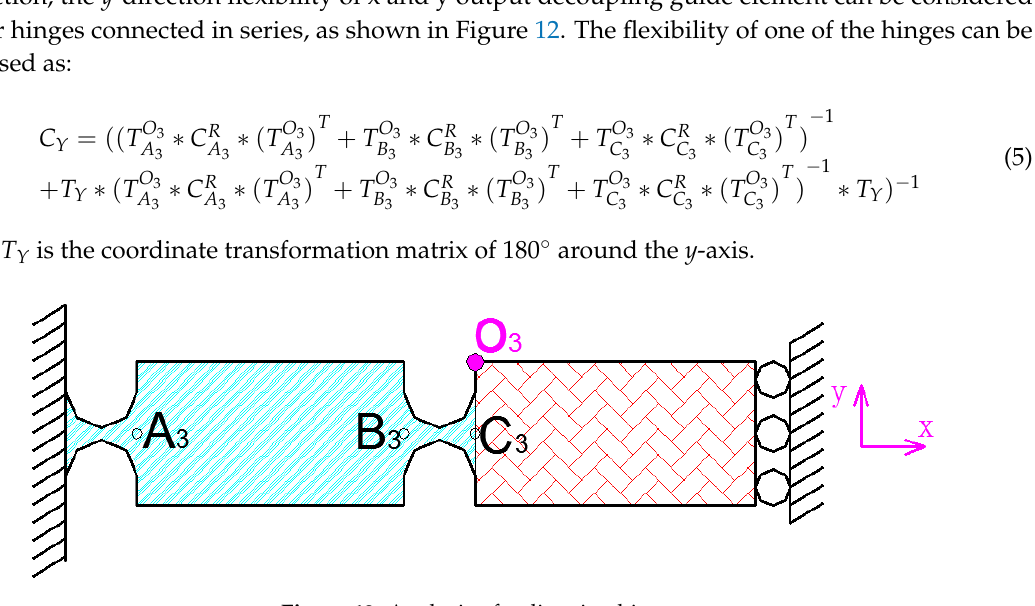
Figure 12. Analysis of y -direction hinge.